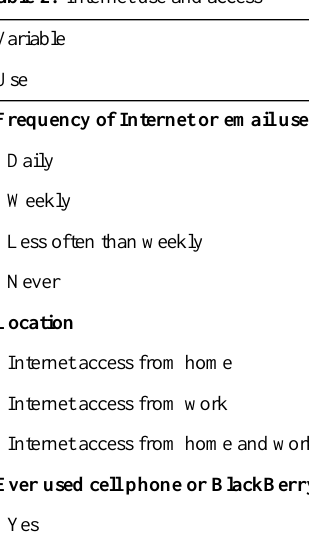
Table 2. Internet use and access